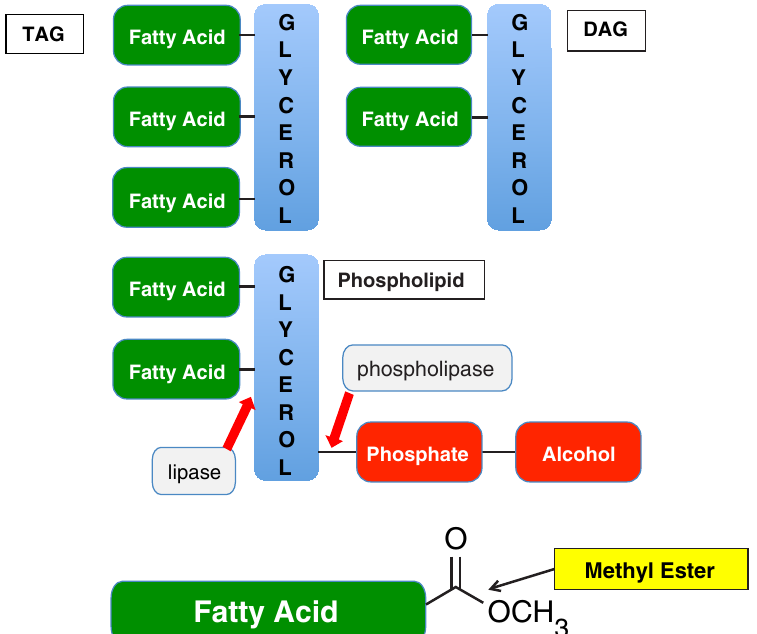
Figure 4. Structures of precursors and product for biodiesel. Top: TAG (triacylglycerol); DAG (diacylglycerol); center: phospholipid; bottom: fatty acid methyl esters (FAMEs) or biodiesel produced through trans-esterification. Phospholipase yields DAG and R-phosphate. Lipase yields